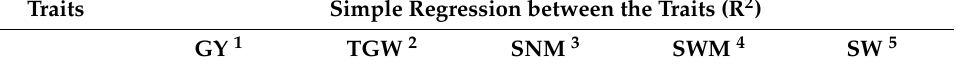
Table 4. Correlations between morphological and physiological parameters and yield components in the rain-fed treatment. *, **, *** significant at the p < 0.05, 0.01 and 0.001 probability levels, respectively. Traits Simple Regression between the Traits (R 2 ) GY 1 TGW 2 Grand mean for years and